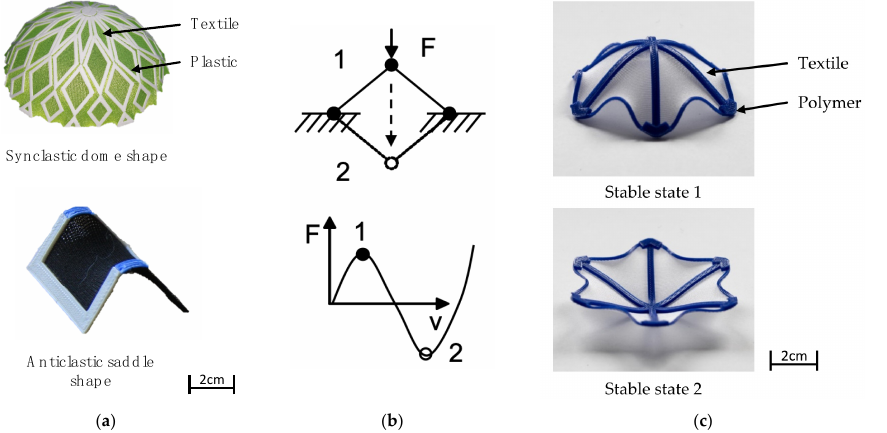
Figure 2. Spatial shapes of 4D textiles and bistability: ( a ) synclastic dome and anticlastic saddle shape; ( b ) bistability principle; ( c ) example of two stable states of one 4D textile structure.